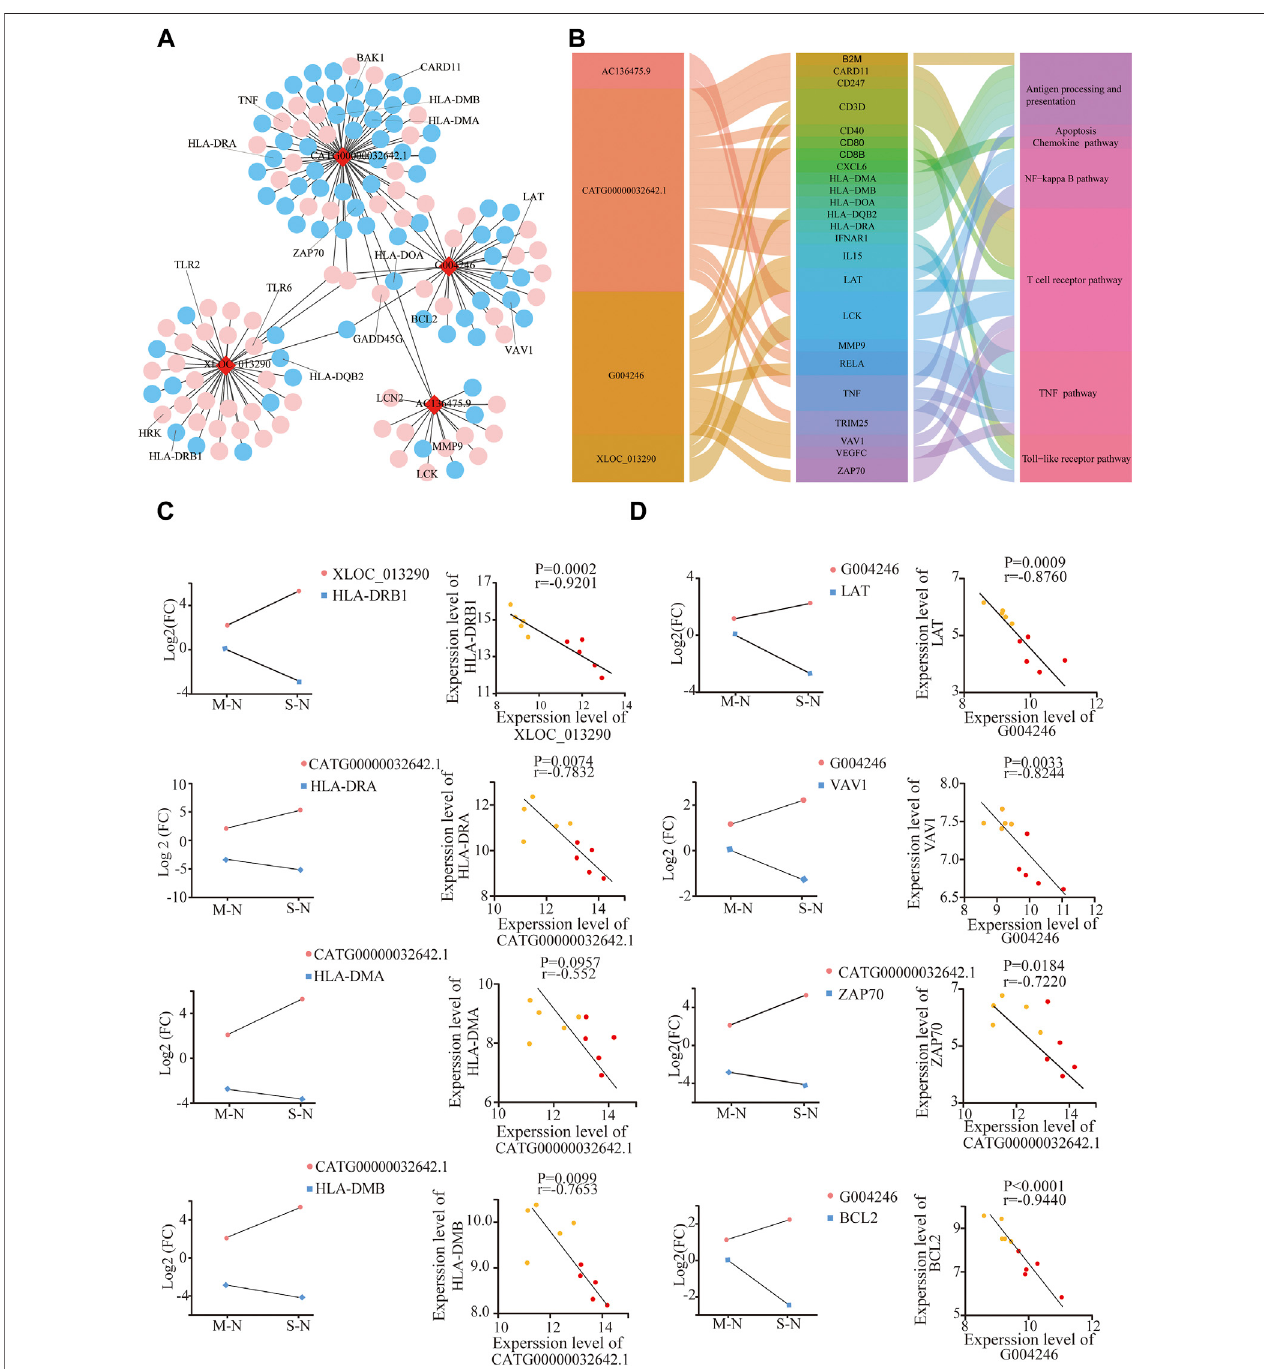
FIGURE 4 | Analysis of the lncRNA – mRNA network in COVID-19. (A) Integrated lncRNA – mRNA network; (B) 4 lncRNA and selected 24 mRNA are shown using the Sankey diagram; (C,D) correlation between lncRNA and targeted mRNAs in mild and severe groups compared to healthy controls, respectively. The Y-axes correspond to the log2FC of lncRNAs and mRNAs. The number of samples: M ( n = 5) and S ( n = 5); mild and severe patients were colored by yellow and red dots, respectively.